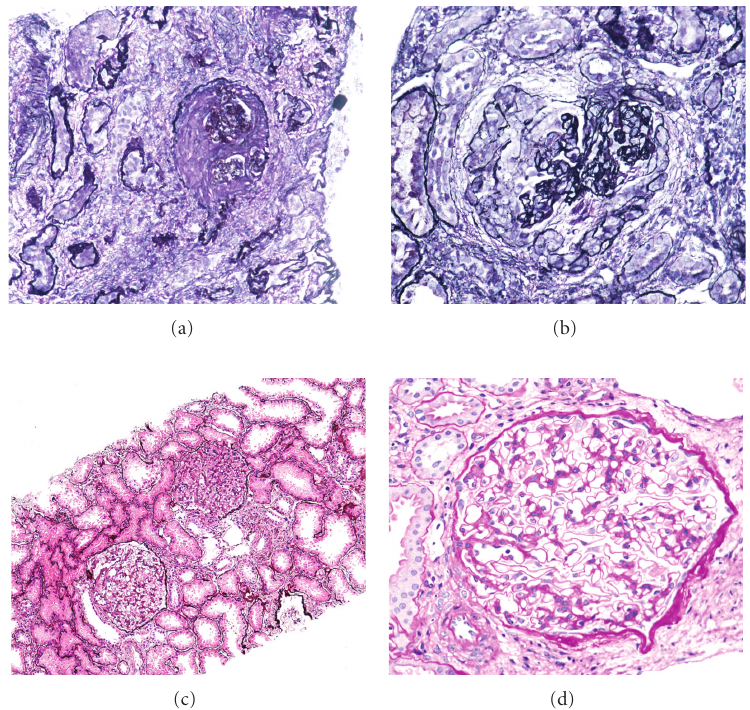
Figure 2: Repeated kidney biopsies in an HSPN patient with acquired IgA deficiency. (a, b) The first kidney biopsy (performed at 7 years old) showing necrotizing crescentic glomerulonephritis with advanced glomerulosclerosis and severe tubulointerstitial nephritis, which was compatible with HSPN grade 5b. (c, d) The fourth kidney biopsy (performed at 21 years old) showing minor glomerular abnormalities. Kidney biopsy samples were stained with periodic acid methenamine silver (a, b, and c), and periodic acid Schi ff (d), respectively. Original magnifications were × 10 (a, c) and × 40 (b, d),